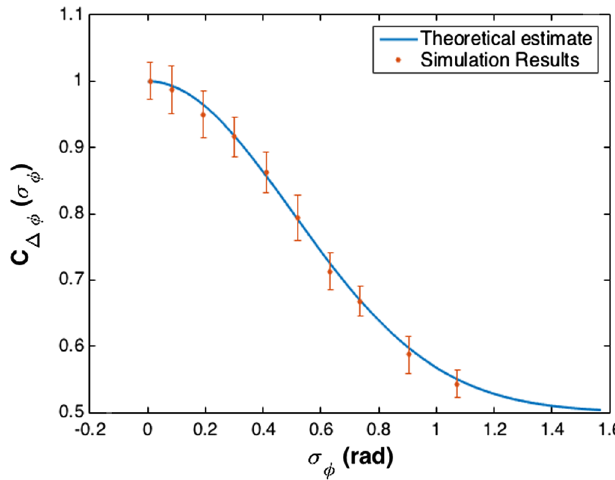
FIG. 14. Normalized transverse emittance growth rate with noise PSD at ¯ ν . Error bars represent (cid:4) σ over ten trials. b